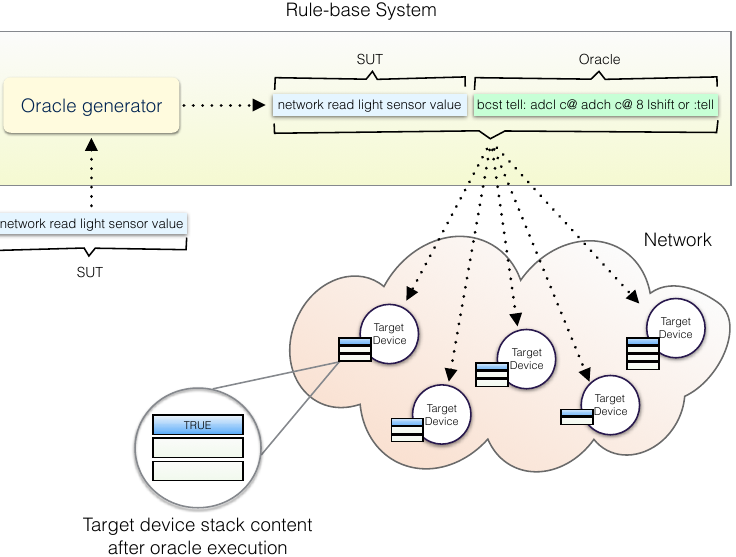
Figure 8. Network sensing task example. A SUT in form of a sentence is broadcast along with the generated oracle. A TRUE value on top of the target device stacks indicates that the programmer implemented the sentence